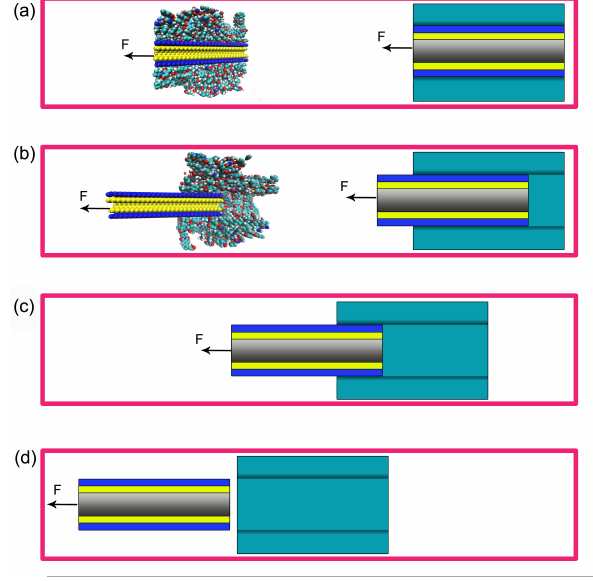
Figure 6: Schematic of the different phases of the pullout simula- tion and what occurs to the matrix (cyan) and the CNT reinforcement, at the (a) initial state, (b) pullout outset (Phase I), (c) coupled move- ment of polymer matrix (Phase II), and (d) complete pullout (Phase III). The insets in (a) and (b) are snapshots taken from the MD trajec- tory